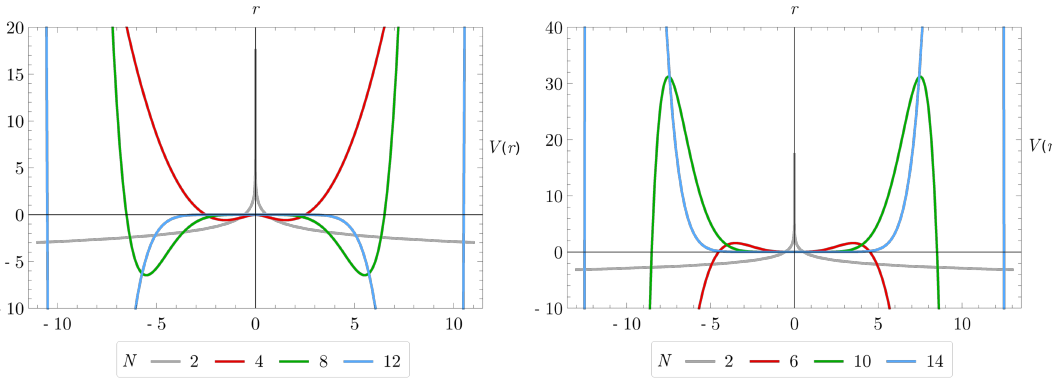
Figure 2 . Plot of the potentials, V ( r ) , for N/ 2 being even (on the left) and odd integers (on the right). For N = 2 , we have V ( r ) = − log | r | (in gray) indicating eigenvalue repulsion in the GUE. For N > 2 we get “double-well” or “double-crest” type potentials, depending on whether N/ 2 is even or